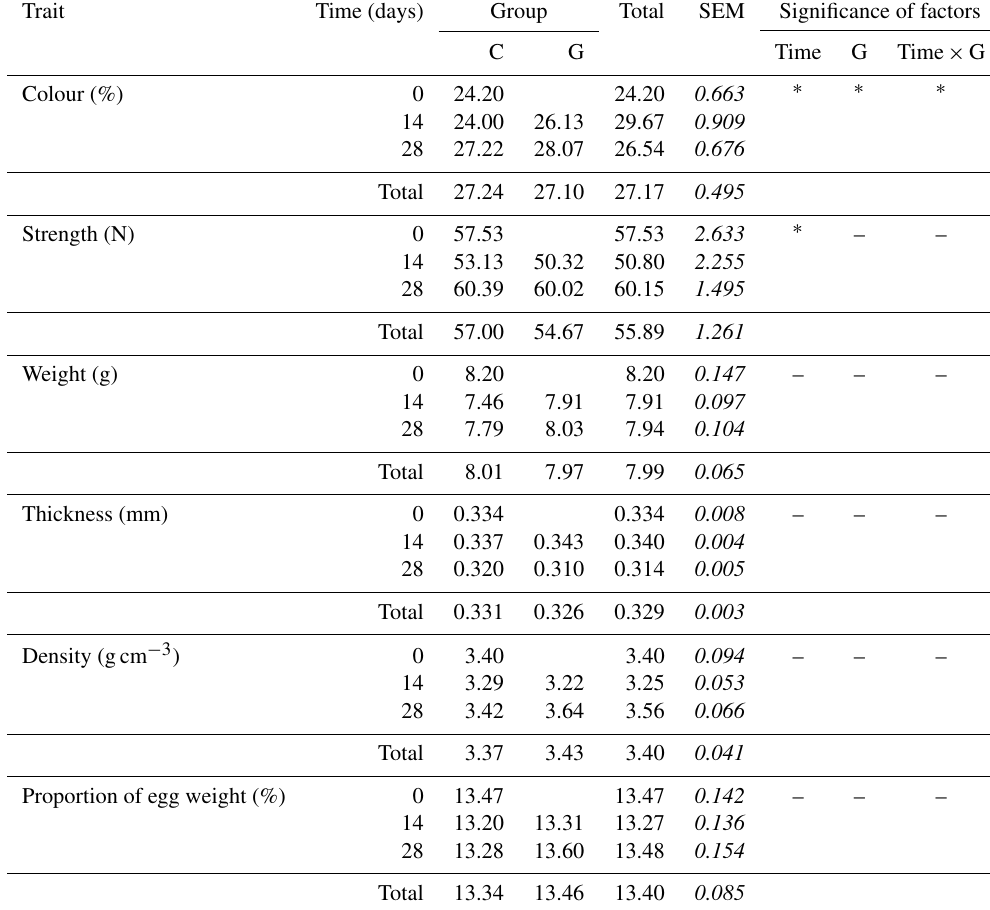
Table 5. Traits of egg shell in the control and experimental groups. Trait Time